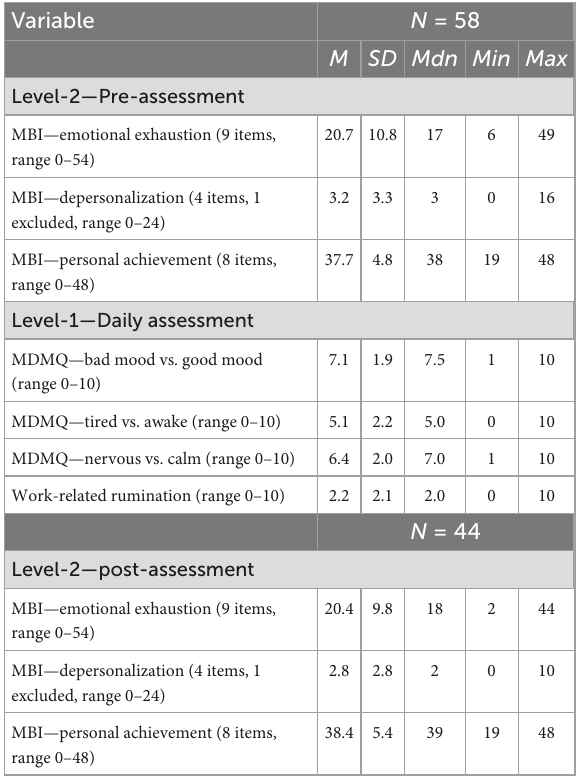
TABLE 3 Descriptive statistics of all (component) scales.